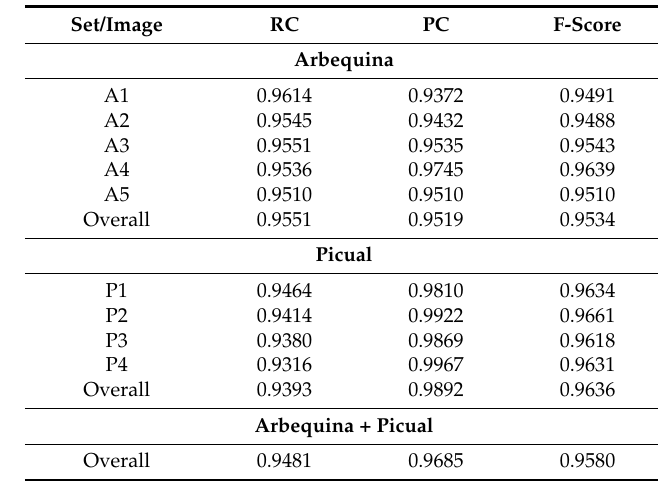
Table 1. Performance of the segmentation algorithm calculated by comparison between the binary images automatically produced and the corresponding ground truths. Results are expressed in terms of Recall (RC), Precision (PC) and F-score, and detailed per variety, subset, and considering all the samples as a